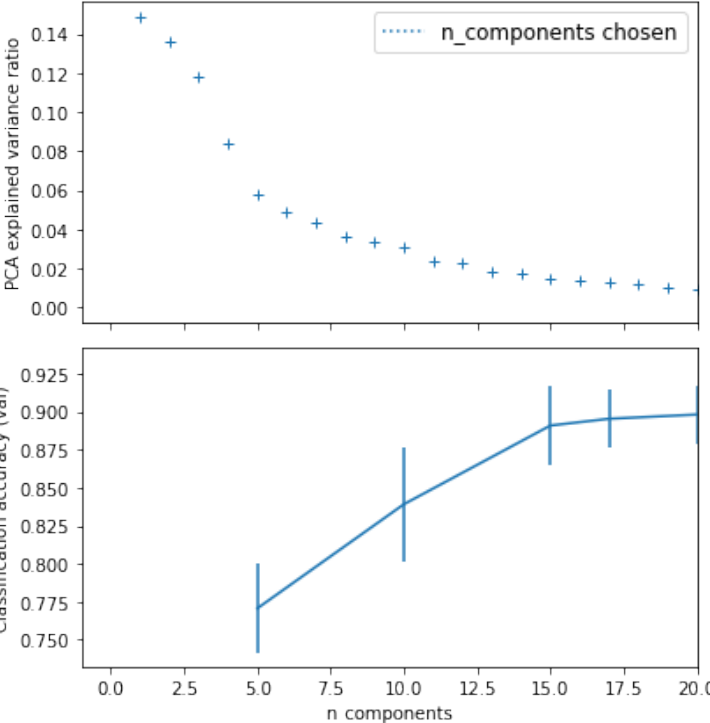
Figure 8. Variance ratio and classification accuracy of principal component analysis (PCA).